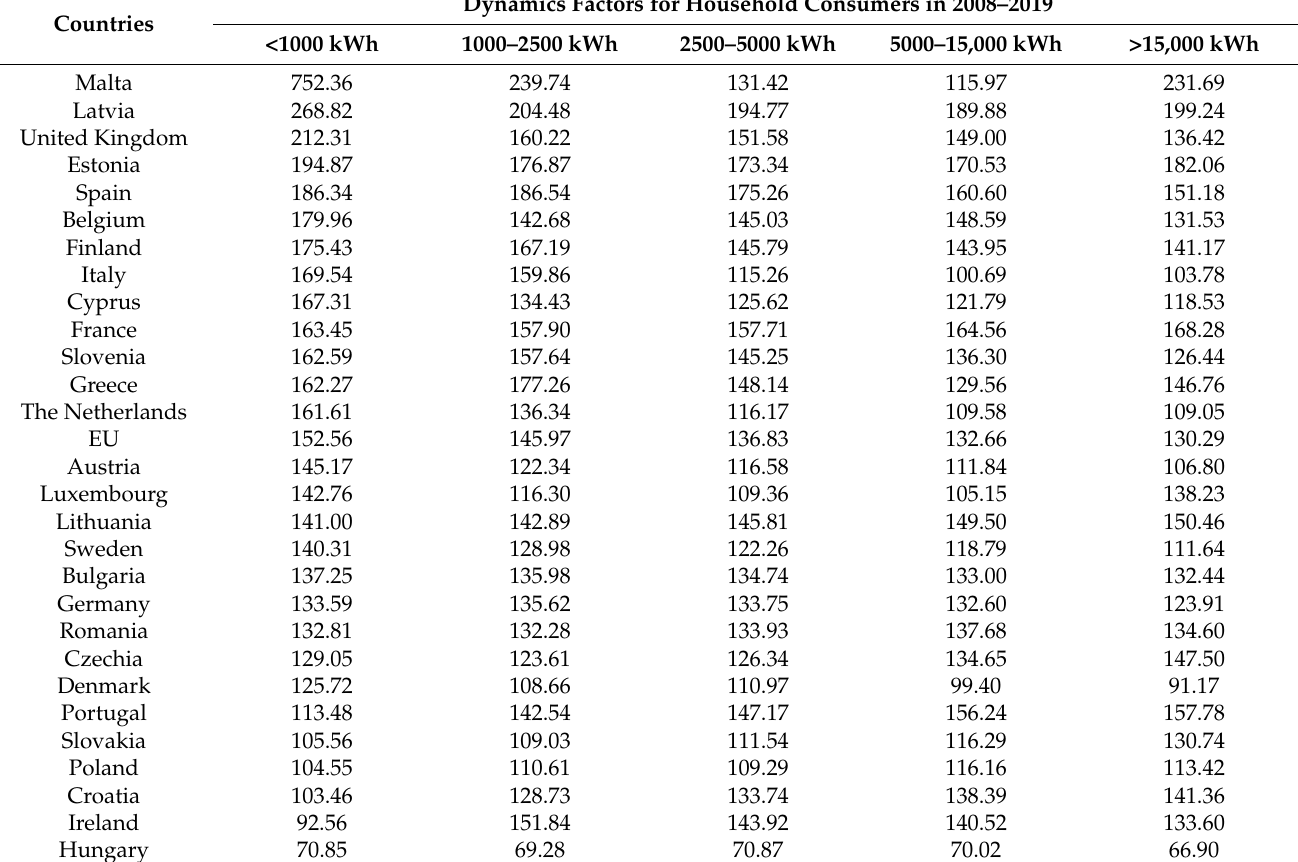
Table 1. Dynamics indicators for electricity prices for household consumers by volume of consumption in EU member states in 2008–2019 (year 2008 = 100).